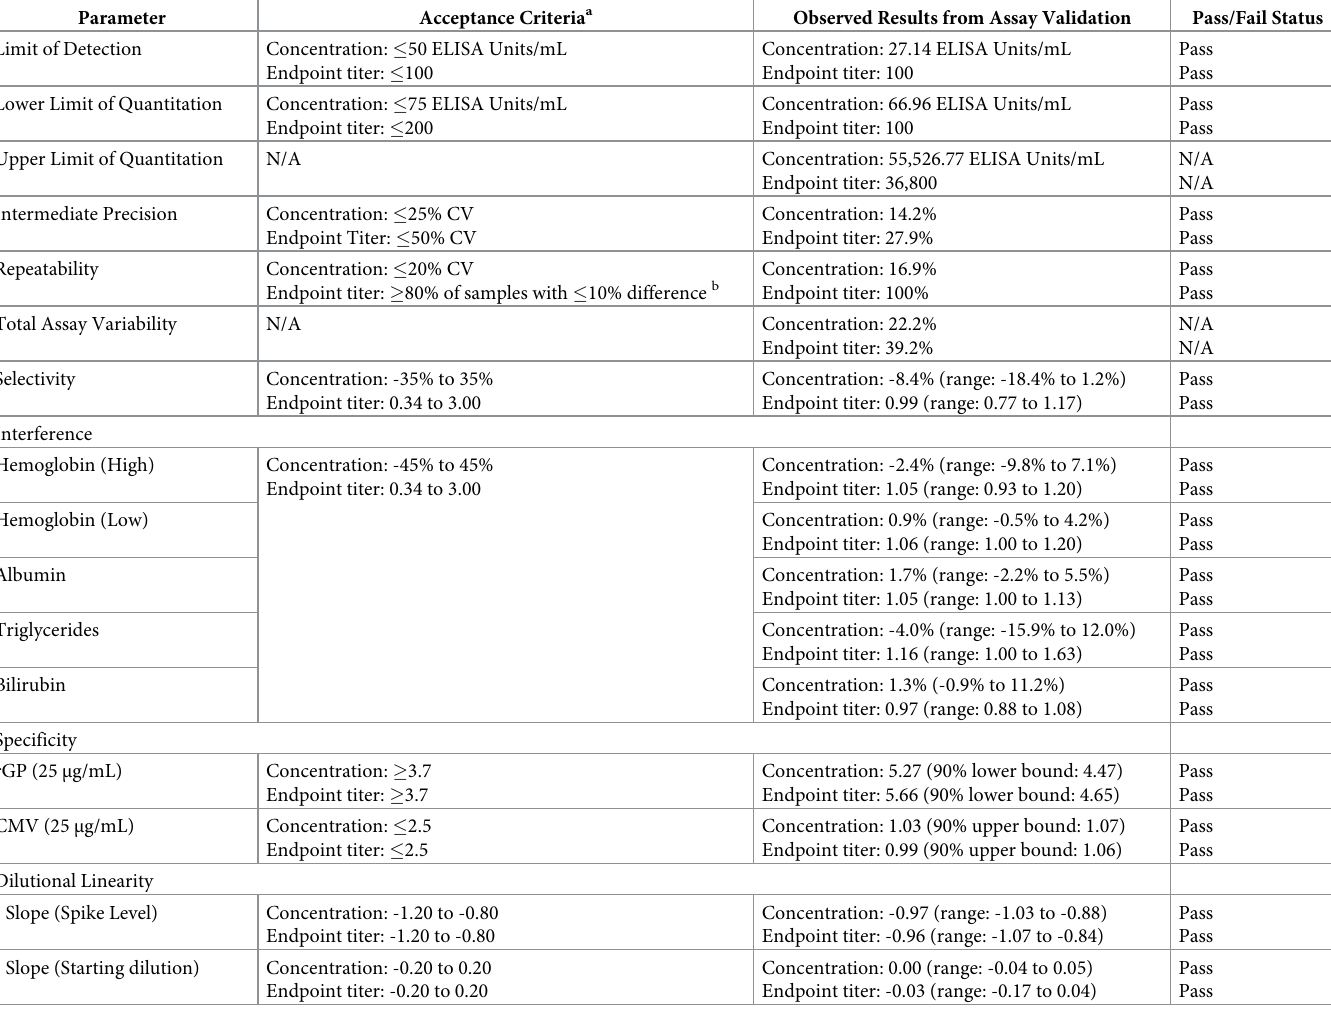
Table 4. Summary of anti-EBOV GP IgG ELISA acceptance and validation